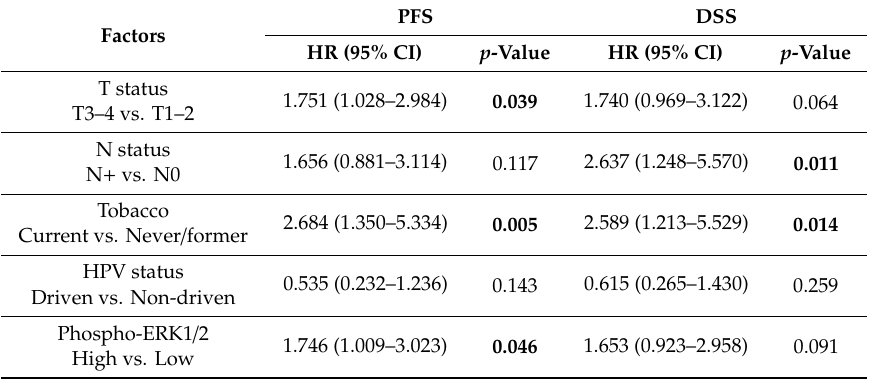
Table 3. Multivariate Cox regression analysis of progression-free survival (PFS) and disease-specific survival (DSS) for oropharyngeal squamous cell carcinoma (OPSCC) patients ( n = 124). Factors